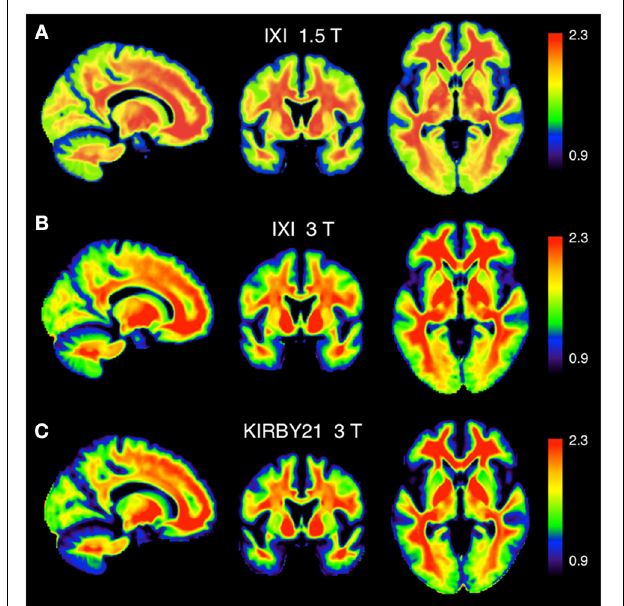
FIGURE 8 | Calibrated T1-w/T2-w images: comparison between different datasets. The group-level T1-w/T2-w image for the IXI 1.5 T (A) , IXI 3 T (B) , and KIRBY21 3 T (C) datasets is shown in sagittal, coronal and axial sections. We use here a common intensity range across datasets (T1-w/T2-w values between 0.9 and 2.3).